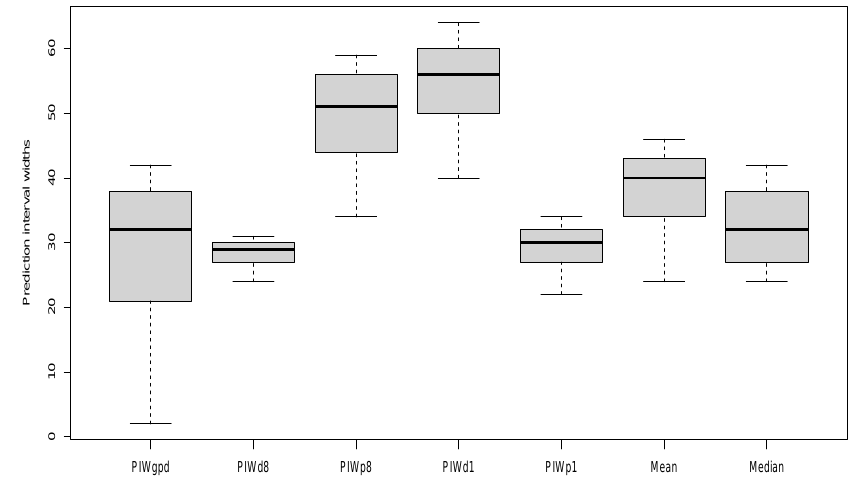
Figure 9. Box plots of PIWs of the models.